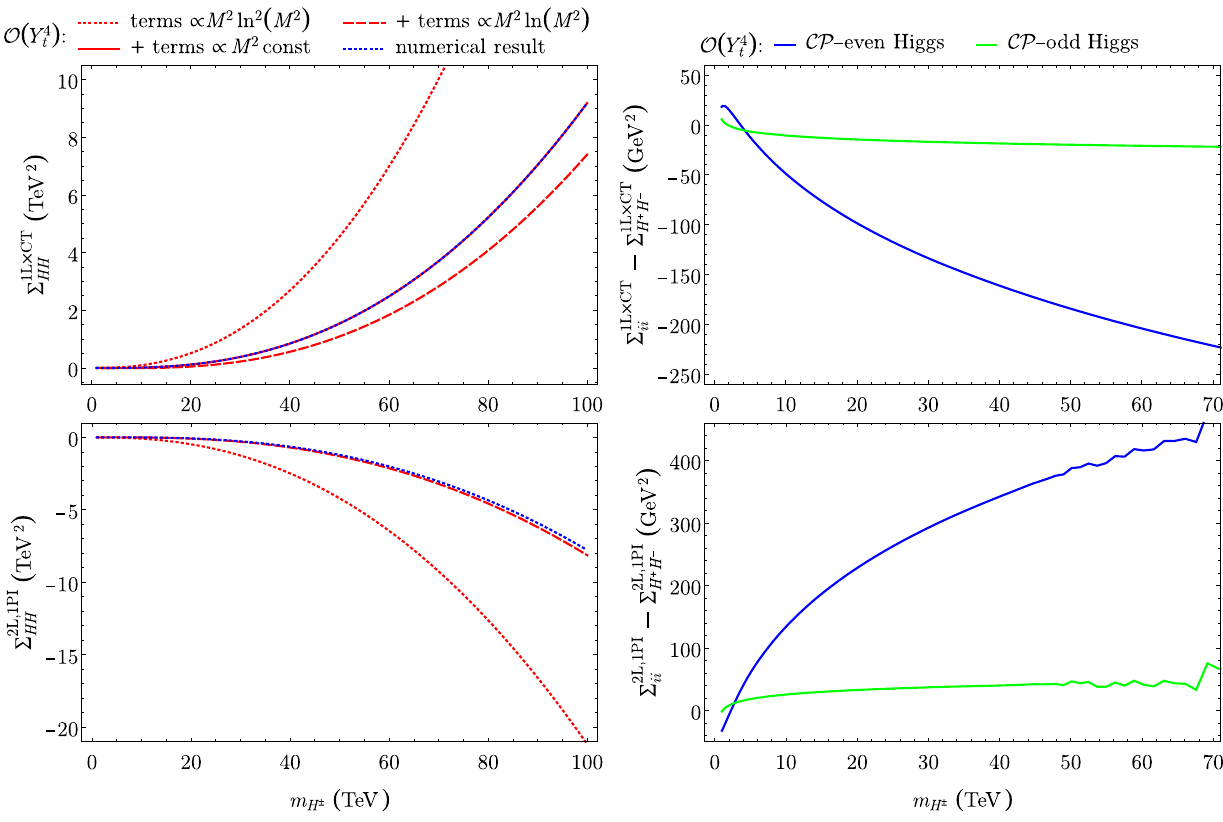
Fig. 7 Contributions of order Y 4 t (by fermion loops) to the diagonal (green) self-energies are of electroweak size. The numerical evaluation self-energies of heavy-doublet Higgs states are displayed. t β = 3 and of the two-loop self-energies has been achieved with TSIL . The wig- the SUSY sector is decoupled (at a scale of 200TeV). Plots on the left- gles for M H ± ≥ 50TeV in the plot in the lower right-hand quadrant / p 2 , with shows that TSIL becomes unstable in this regime. The corresponding hand side show the convergence of the expansion in M 2 EW instabilities appear at much lower mass values ( ∼ TeV) for the contri- p 2 ∼ M 2 . For the case of two-loop integrals, we only extracted ana- H ± butions of the bottom quark, justifying our choice of displaying only lytically the logarithmic terms, which is why there is no solid red line in the order Y 4 t and considering the low value of t β = 3, where the bottom the lower plot. Plots on the right-hand side show the cancellation with contributions are correspondingcharged-Higgsself-energies,interveninginthecountert- erm. Resulting diagonal contributions to the CP -even (blue) or CP -odd